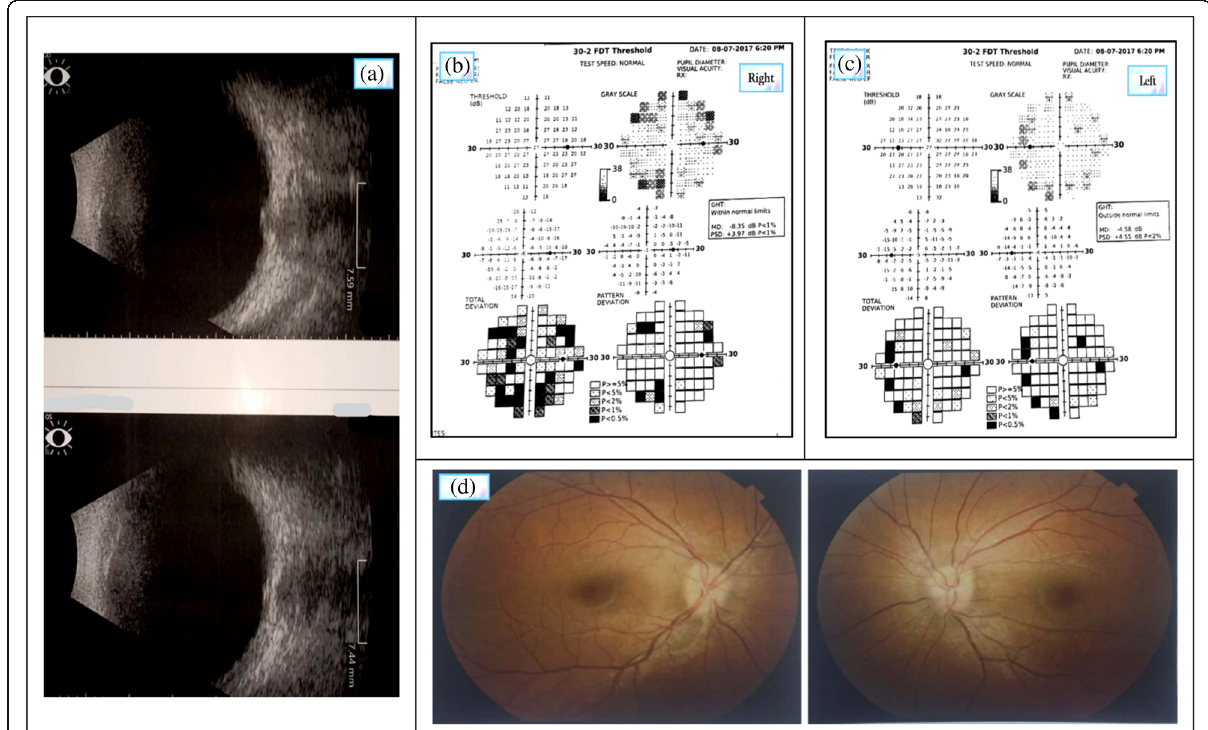
Fig. 2 Baseline ophthalmological assessment of an IIH patient showing a dilated right and left optic nerve sheath diameter (7.59 and 7.44 mm respectively), b , c asymmetrical visual field affection with decreased mean deviation of the automated visual field examination of right and left eyes ( − 8.35 and − 4.58 respectively), and d fundus color photography showing bilateral grade III